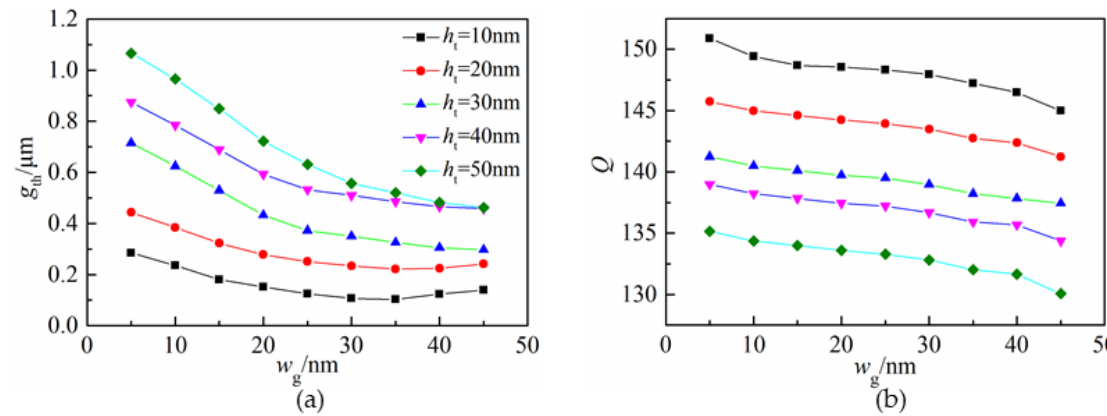
Figure 5. The change of gain threshold and quality factor with the structures ( a ); threshold, g th ; and ( b ) quality factor, Q .